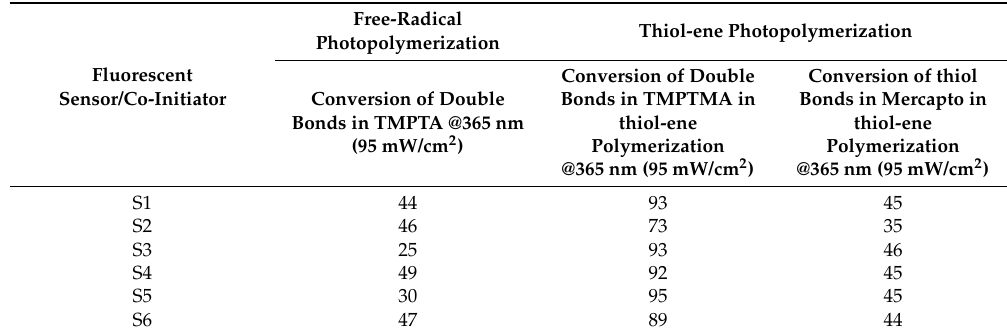
Table 5. Functional group conversions of acrylate monomer for TMPTA, and thiol and methacrylate monomers for thiol-ene photopolymerization process, using photoinitiating system based on diphenyliodonium hexafluorophosphate (HIP wt 1%) and 2-amino-4,6-diphenyl-pyridine-3-carbonitrile derivatives in the role of co-initiator at 365 nm exposure.